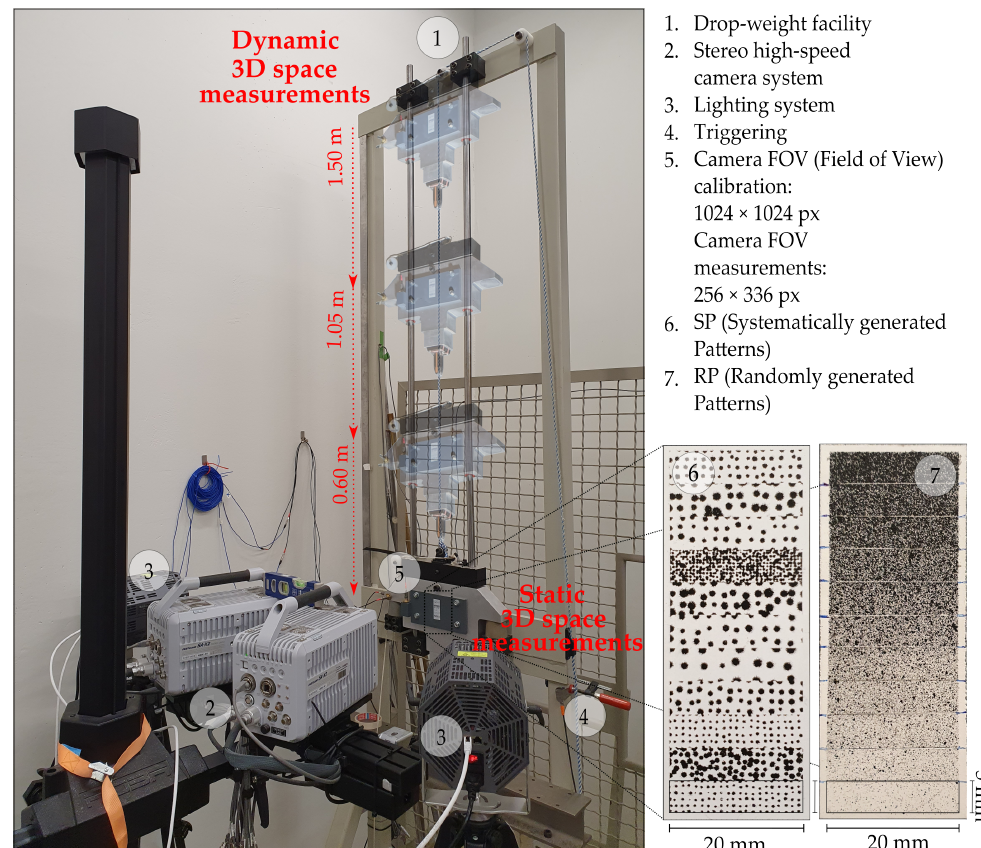
Figure 1. Measurement system configuration for static and dynamic event conditions. Table 1. Main technological specifications of the high-speed camera “Photron Fastcam SA-X2” . Data from